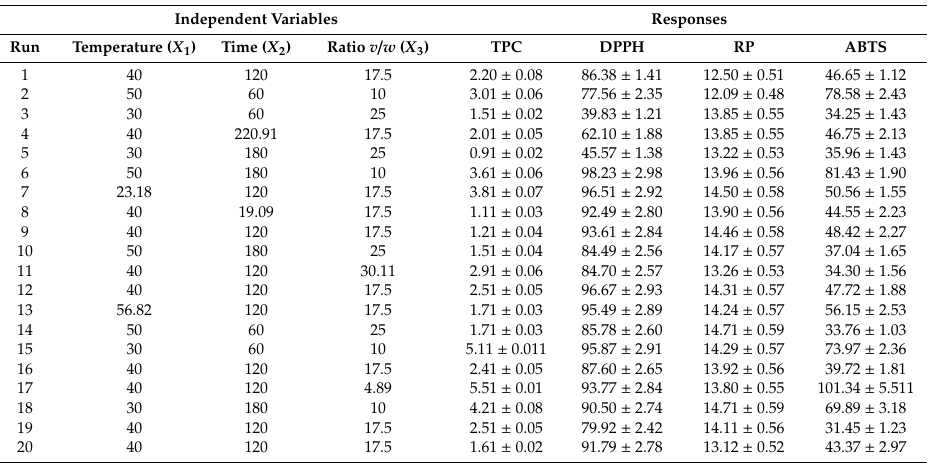
Table 1. Experimental factors and measured values of responses. The extraction factors were temperature in ◦ C ( X 1 ), time in minutes ( X 2 ), and ratio v / w (mL / g) ( X 3 ). The responses were measured in triplicate as total phenol content (TPC) expressed as mg gallic acid / g BSG and antioxidant activity, by DPPH, RP, and ABTS methods expressed as % inhibition, mg ascorbic acid / g BSG, and %, respectively. Values are reported as mean ± SD ( n =